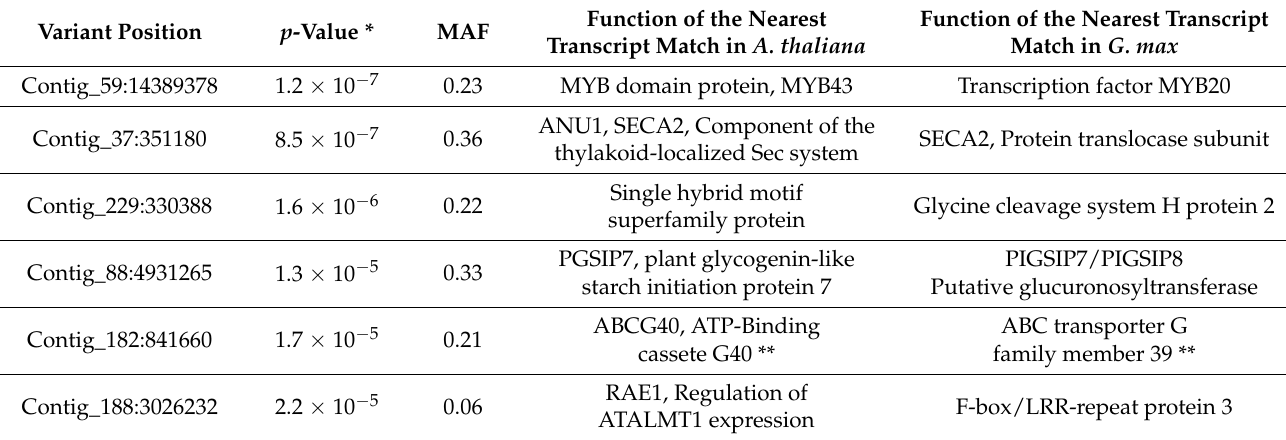
Table 1. Variants associated with the percentage of mature beans in guar at p -value < 1 × 10 − 4 .